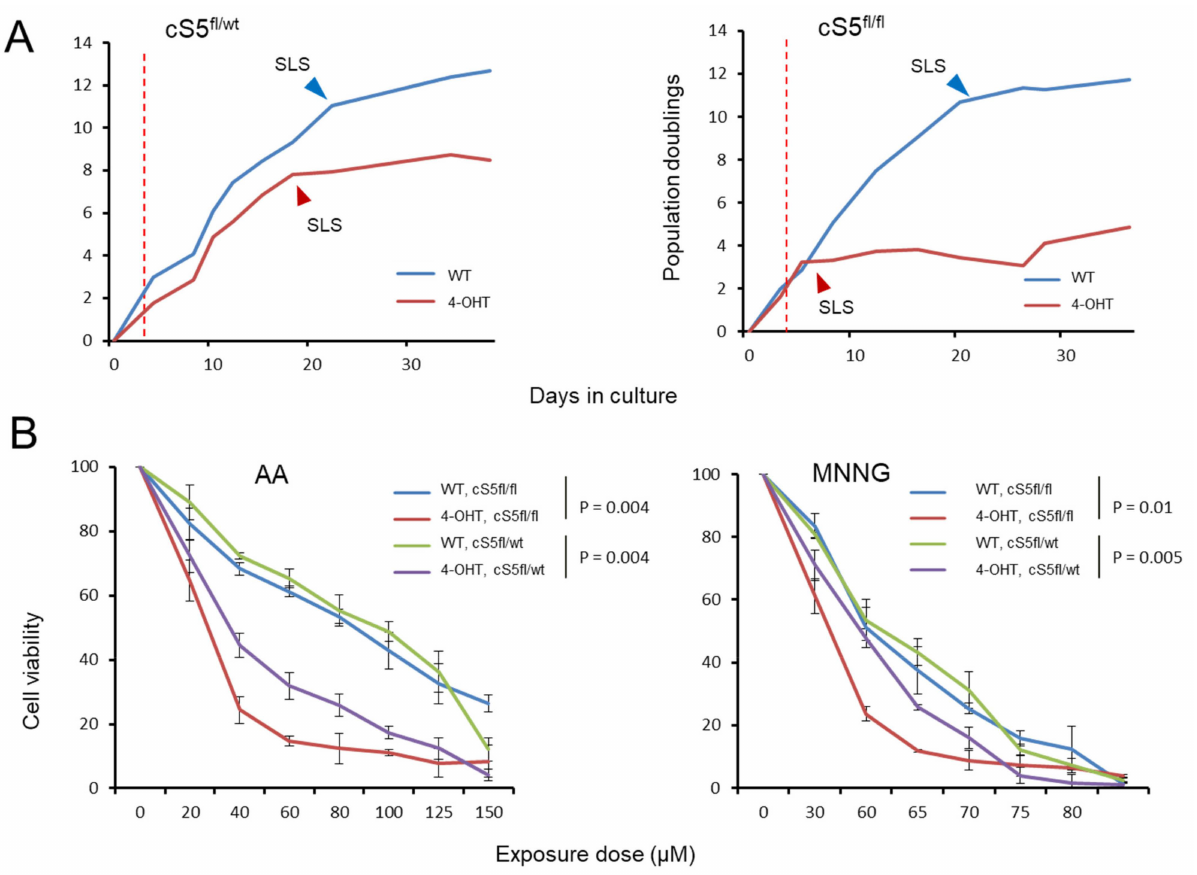
Figure 4. Impact of the stepwise Smarca5 deletion on cell growth and cell viability upon genotoxic insults. ( A ) Growth curve for the Smarca5 knockout MEFs when grown in culture for prolonged periods of time, ( left ): single allele knockout, ( right ): double allele knockout. Red dotted lines indicate the point of 4-OHT induction, arrowheads indicate the onset of senescence-like state (SLS). ( B ) Cell viability of single and double allele knockout Smarca5 MEFs as measured by MTS assay upon exposure to different doses of AA in triplicates ( left ) and MNNG ( right ). NOTE: p -values in ( B ) are based on paired t -test for each genotype